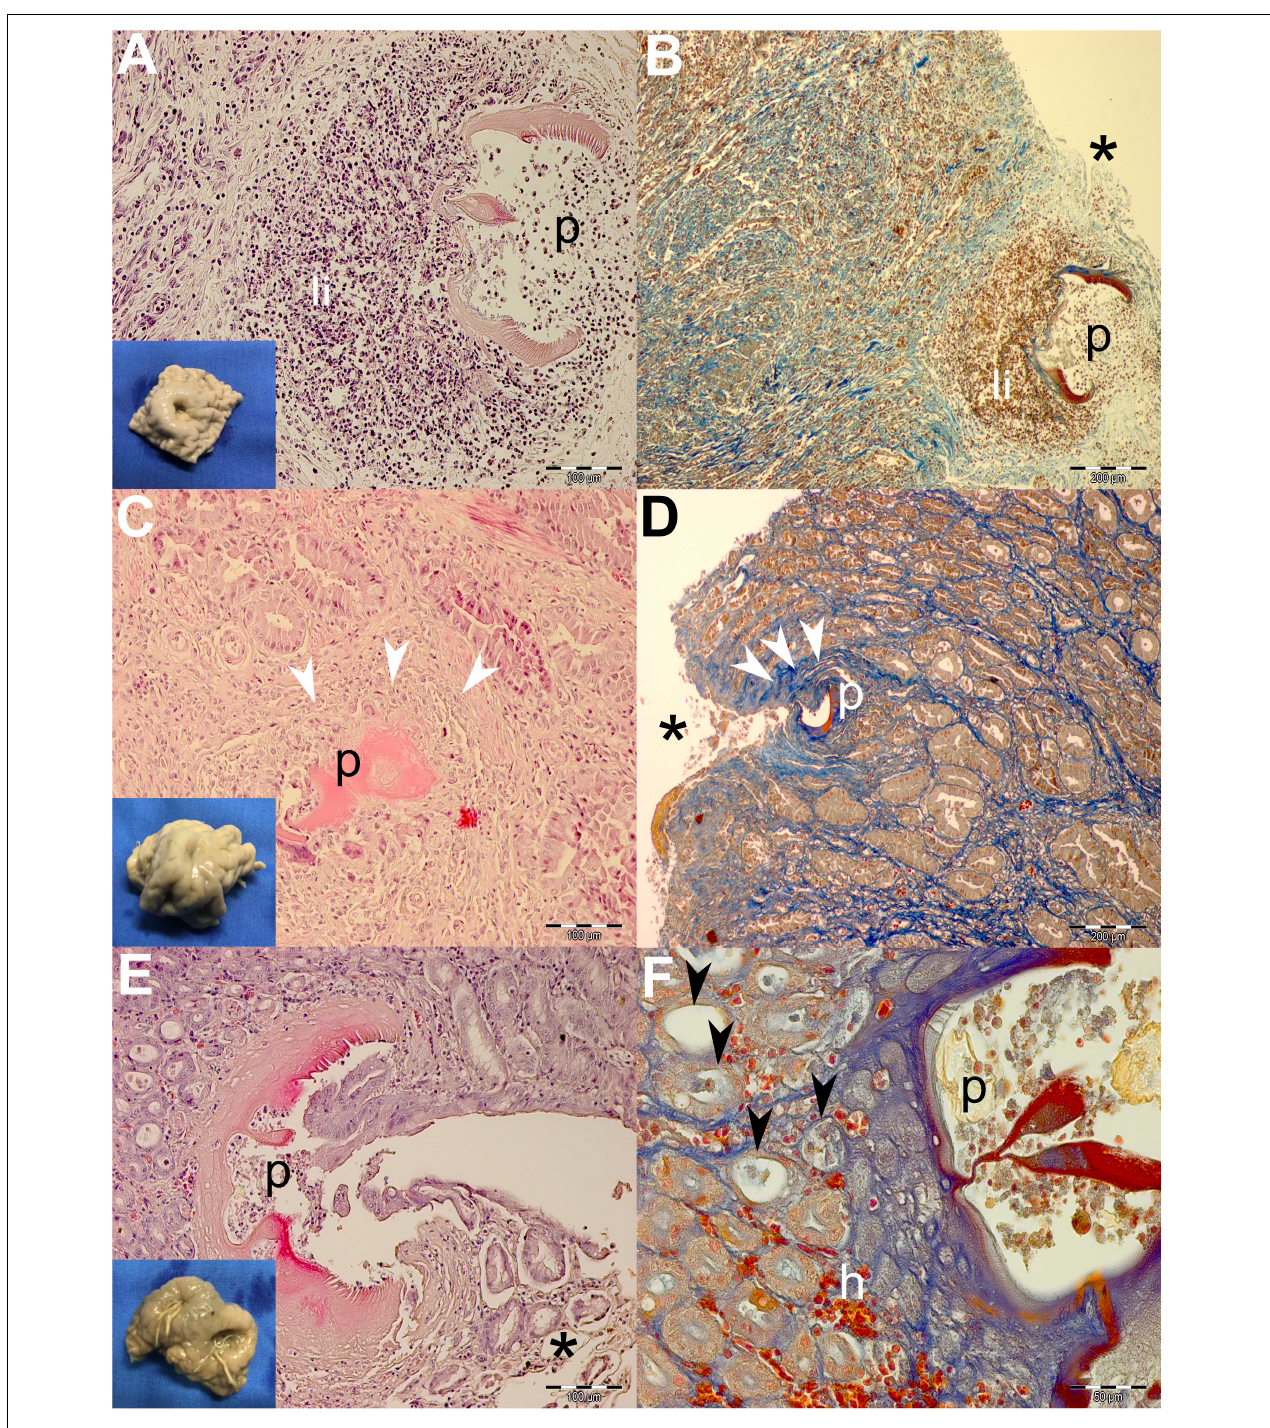
FIGURE 3 | Gross pathological (insets) and histopathological findings of gastric lesions in California sea lions ( Zalophus californianus ) necropsied at the Marine Mammal Care Center in San Pedro, California, United States (spring and summer 2017 and 2018), affected by parasites of Anisakidae family. (A) Mixed leukocytic infiltrate in the lamina propria of gastric mucosa surrounding transversal section of the anisakids, stained by H&E and Mallory’s trichrome stain (MTS) (B) . (C) Deposition of collagen fibers around anisakid body consistent with the formation of granulation tissue and the beginning of the healing process in deeper lamina propria and superficially among gastric acini (D) . (E) Superficial penetration of the anisakid among gastric acini and consequent epithelial necrosis. (F) Miniscule hemorrhaging and ectasis of gastric acini after sloughing of the cuboidal epithelia, forming at the anisakid attachment site. h, hemorrhage; li, mixed leukocytic infiltrate; p, parasite; *, necrosis; white arrowheads, connective tissue fibrosis; black arrowheads, ectasis of gastric acini. Scale bars: 50 (F) , 100 (A,C,E) , and 200 µ m (B,D) . Staining: H&E (A,C,E) and MTS (B,D,F) .